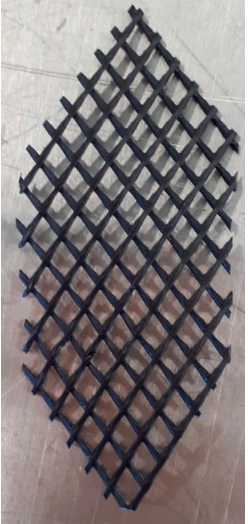
Figure 2. Photograph of the spacer used inside the ED channels.